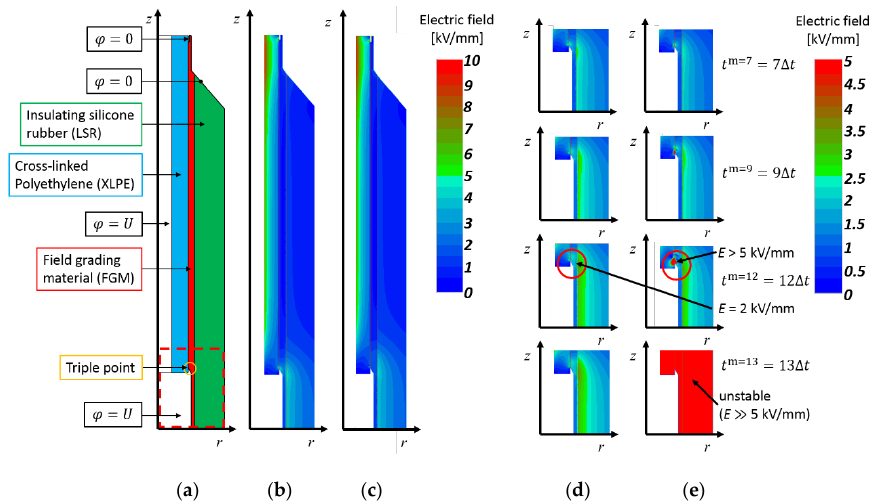
Figure 22. ( a ) Geometry of cable joint, using field grading materials; ( b ) initial electric field; ( c ) stationary electric field, computed with (11); ( d ) electric field, computed with (11) at the time t = t n , with n = 7, 9, 12 and 13; ( e ) electric field, computed with (8)–(10) at the time t = t n , with n = 7, 9, 12 and 13. Inaccurate electric field values are seen after n = 12 [59,109].